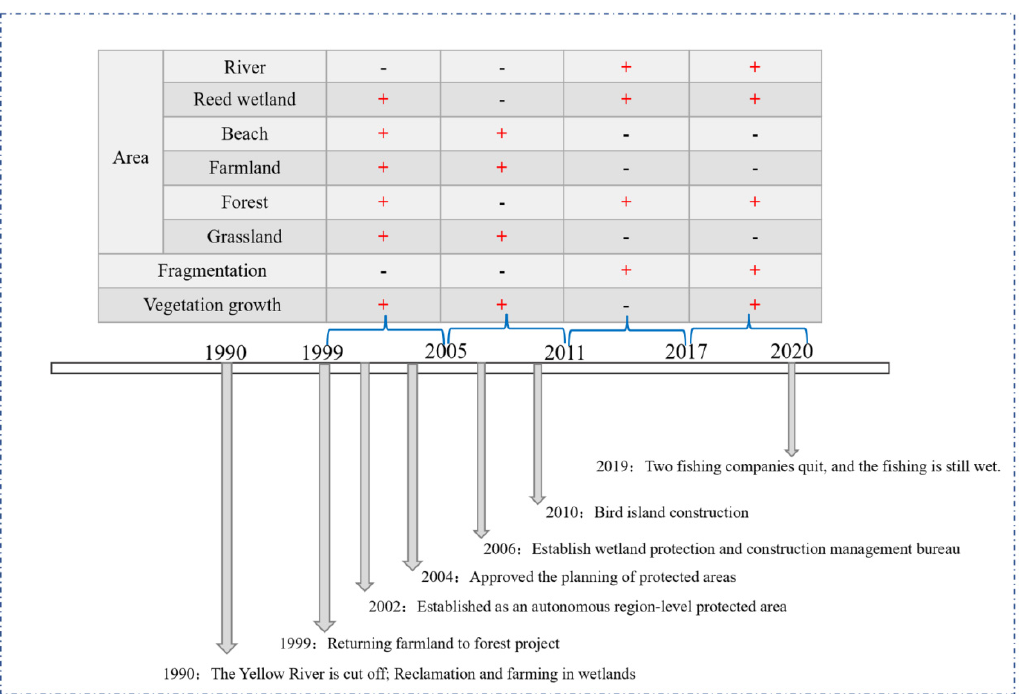
Figure 13. Time distribution plot of change patterns (note: red “+” indicates an increase in interannual variables, black “-” indicates a decrease in interannual variables).